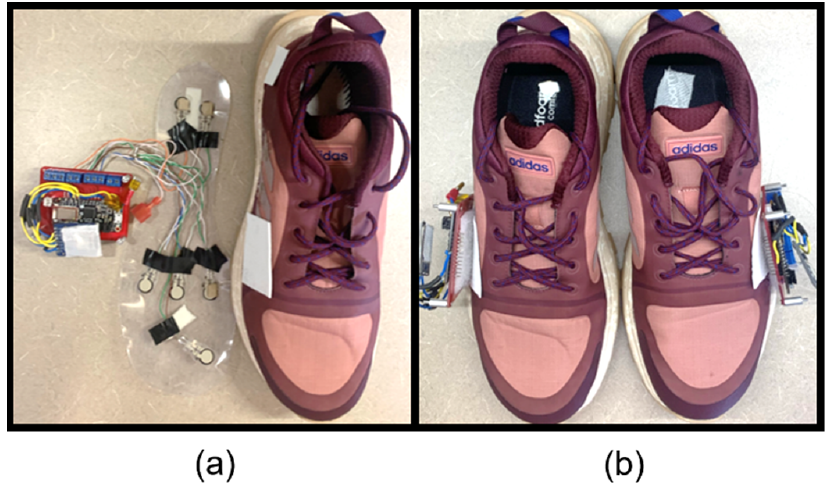
Figure 2. Complete footwear sensor system for women: ( a ) women’s size 8.5 with P2S2s and ( b ) a pair of shoes assembled for testing.